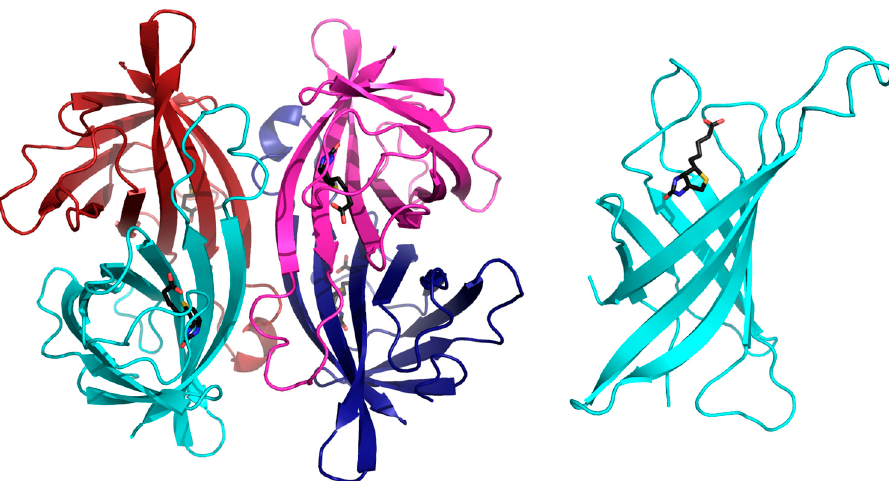
Figure 1. Three-dimensional structure of avidin, as a representative of the tetrameric avidins. The left image displays a cartoon representation of the tetrameric assembly of avidins where each monomer is depicted in magenta, blue, cyan and red. Each monomer has a single biotin (shown in black) binding site. The right image shows the avidin monomer consisting of an 8-anti parallel stranded β -barrel topology with the biotin molecule (shown in black) at the wide end of the barrel (monomer size not to scale compared to the tetramer).